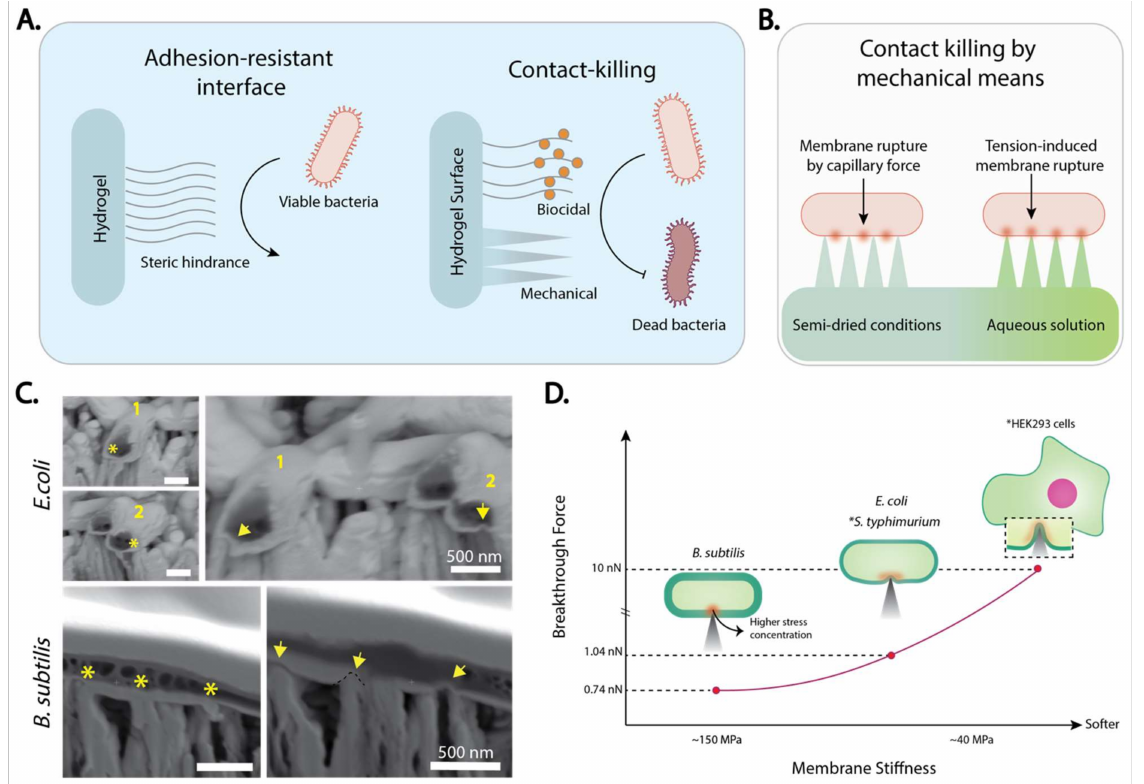
Figure 8. Bactericidal nanostructures fabricated in BC. ( A ) Typical antibiofouling and antimicrobial strategies implemented on hydrogels and very compliant materials. ( B ) Contact-killing via mechanical means can be the result of capillary forces in the air-liquid interface as well as tension-induced mechanical rupture. ( C ) Indentation of the bacterial envelope in Escherichia coli and Bacillus subtilis in contact with nanostructured BC. The asterisks and arrows indicate the indentation left on the bacterial envelope by the BC’s nanostructures before and after the cross-sectional cut, respectively; ( D ) average force values necessary to penetrate B. subtilis, E. coli, S. typhimurium , and HEK93 cells as a function of the membrane stiffness. Reproduced with permission from [20]. (Copyright © 2022, American Chemical